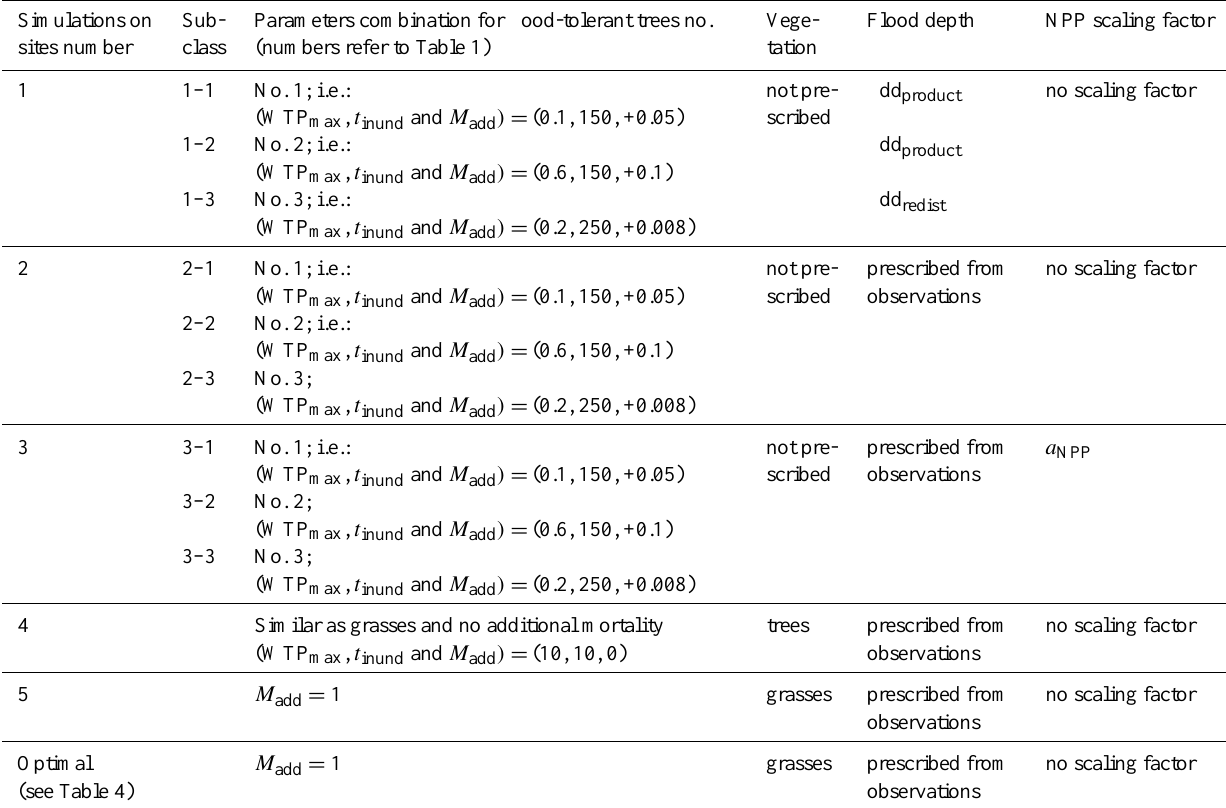
Table 3. Set-up for simulations on sites. The parameter combinations (WTP max , t inund and M add ) refer to Table 1. “Trees”-prescribed vegetation means that forest occupies 95% of the grid cell (see